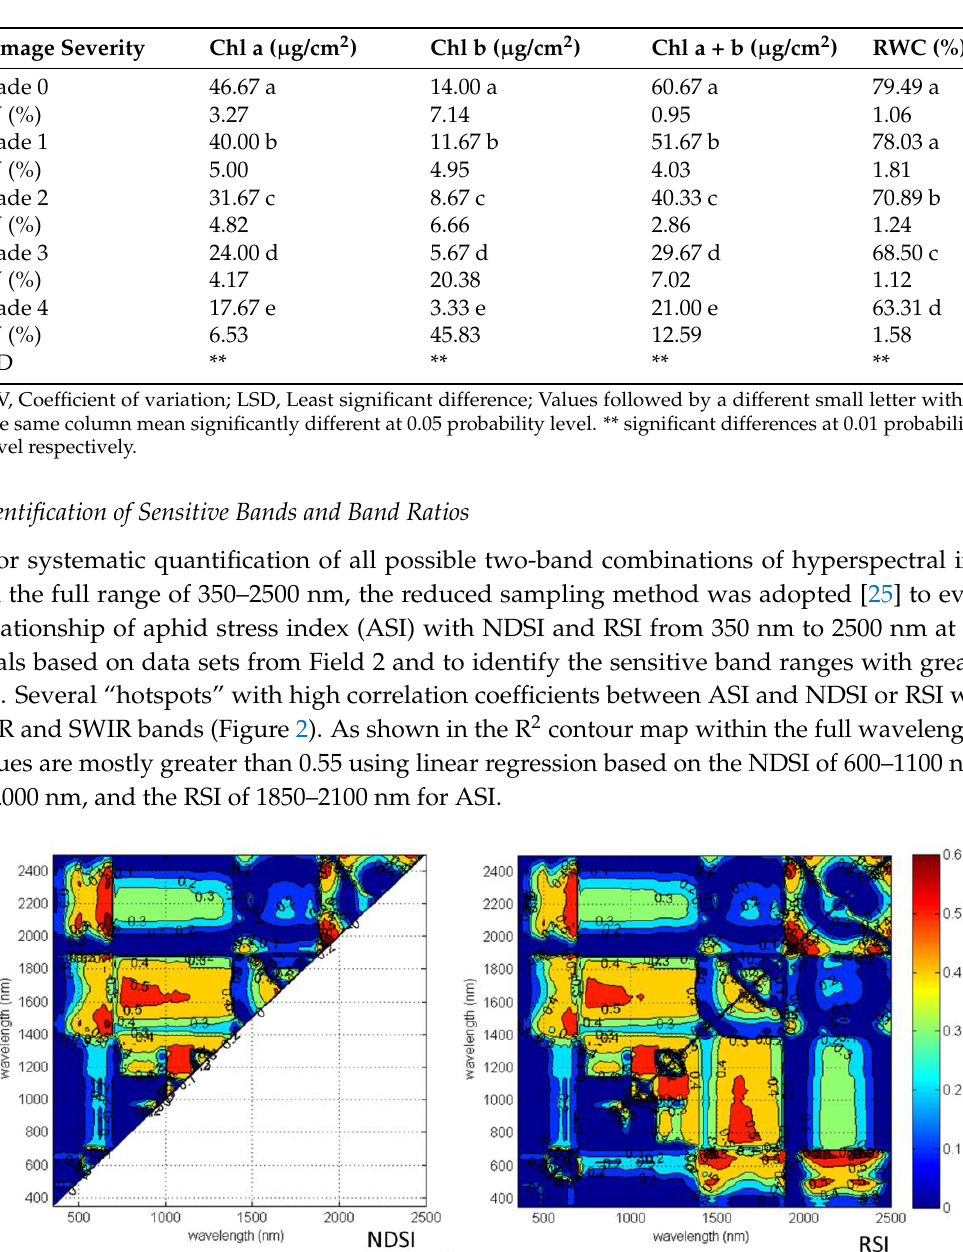
Table 5. Mean chlorophyll concentration and relative water content (RWC) in cotton plants with varying levels of aphid severity.